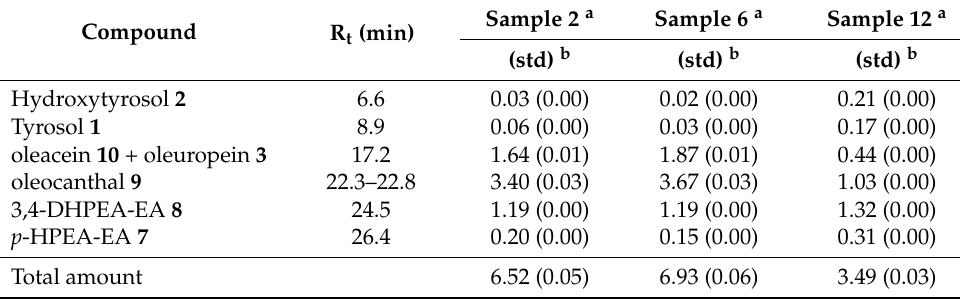
Table 5. Quantitative HPLC analyses of samples 2, 6 and